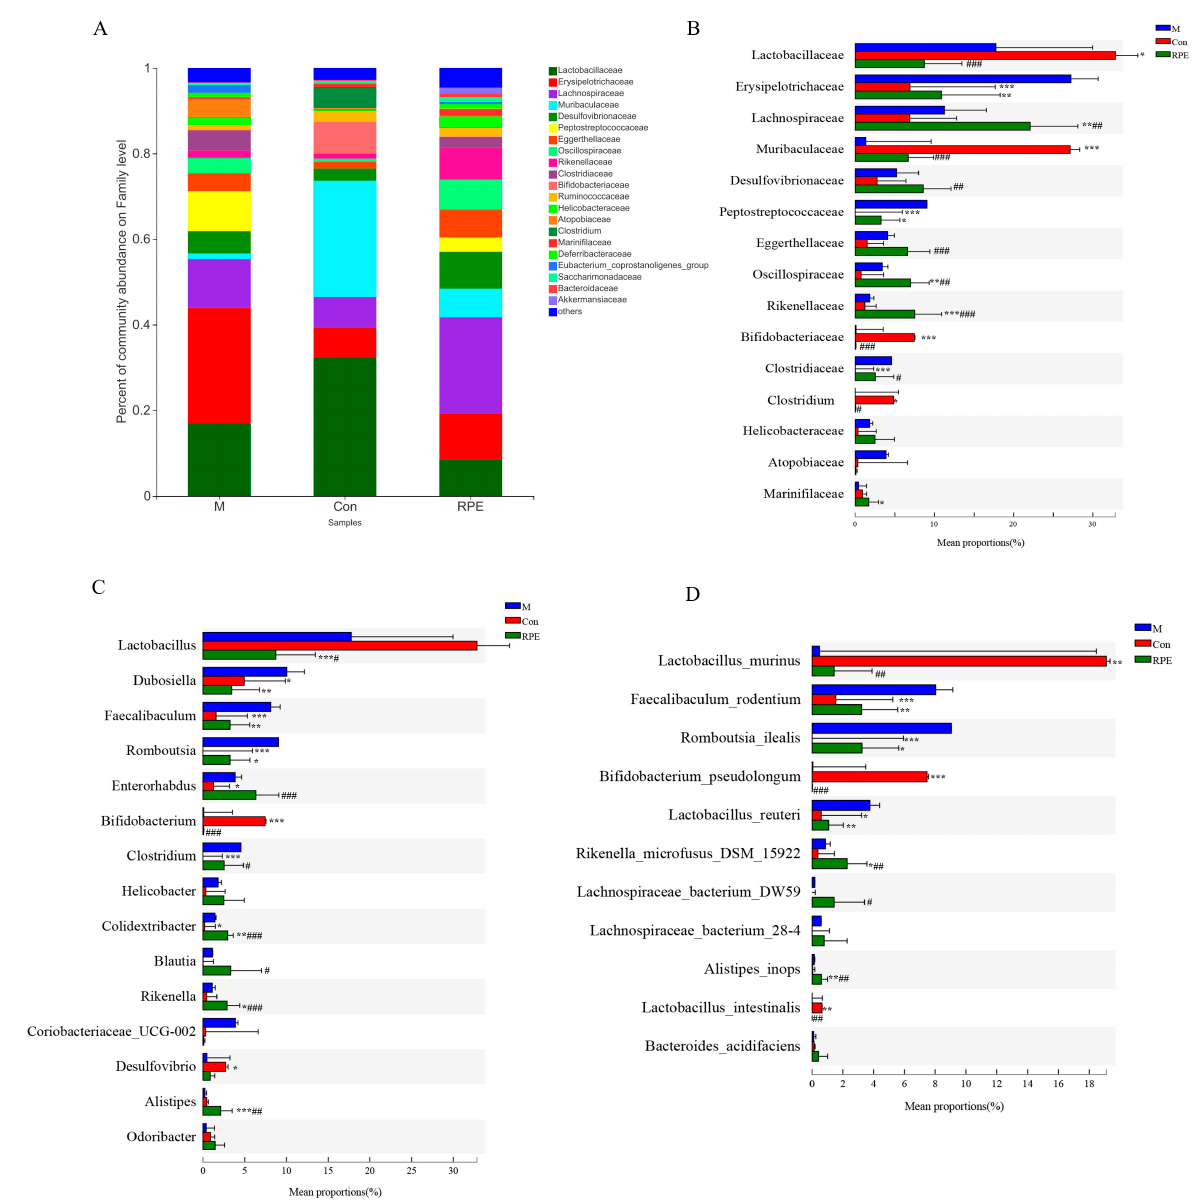
Figure 5. Effects of Rosa roxburghii fruit polyphenols extract on gut microbiota at family ( A , B ), genus ( C ), and species ( D ) level. Note: * p < 0.05, ** p < 0.01, and *** p < 0.001 versus the M group; # p < 0.05, ## p < 0.01, and ### p < 0.001 versus the Con